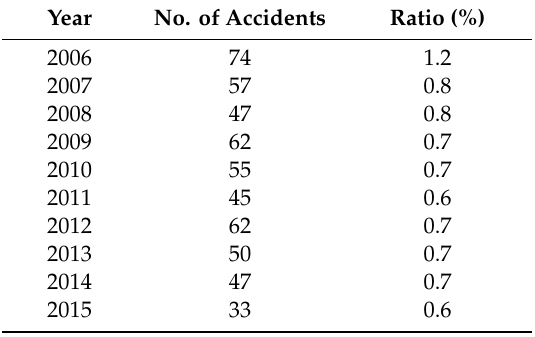
Table 3. The number of annual electrical equipment accidents caused by dust and salt damage.